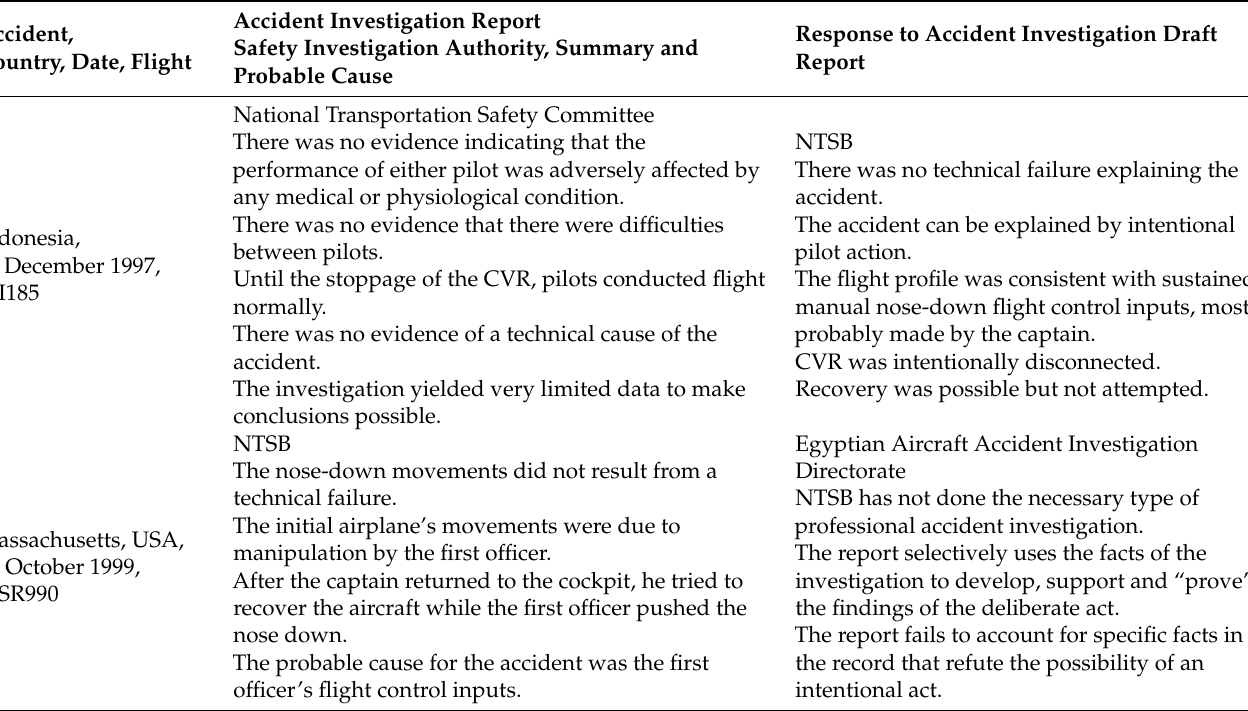
Table 3. Accidents Occurred in Indonesia and Massachusetts: Official Accident Report vs. Response to Accident Investigation Draft Report